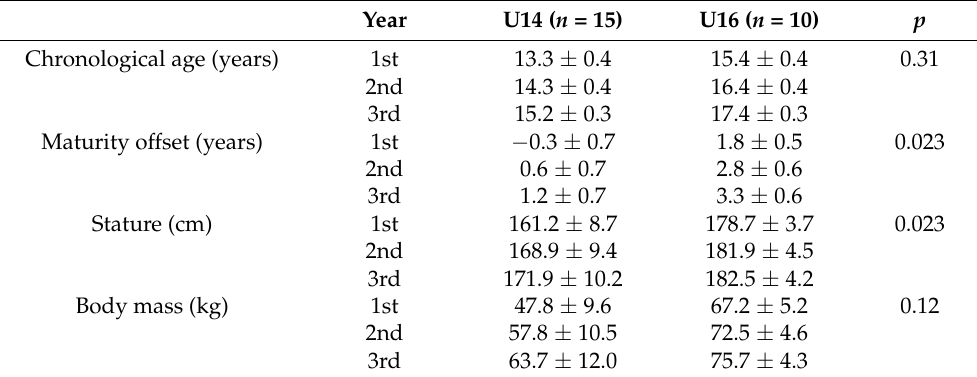
Table 1. Anthropometric characteristics of